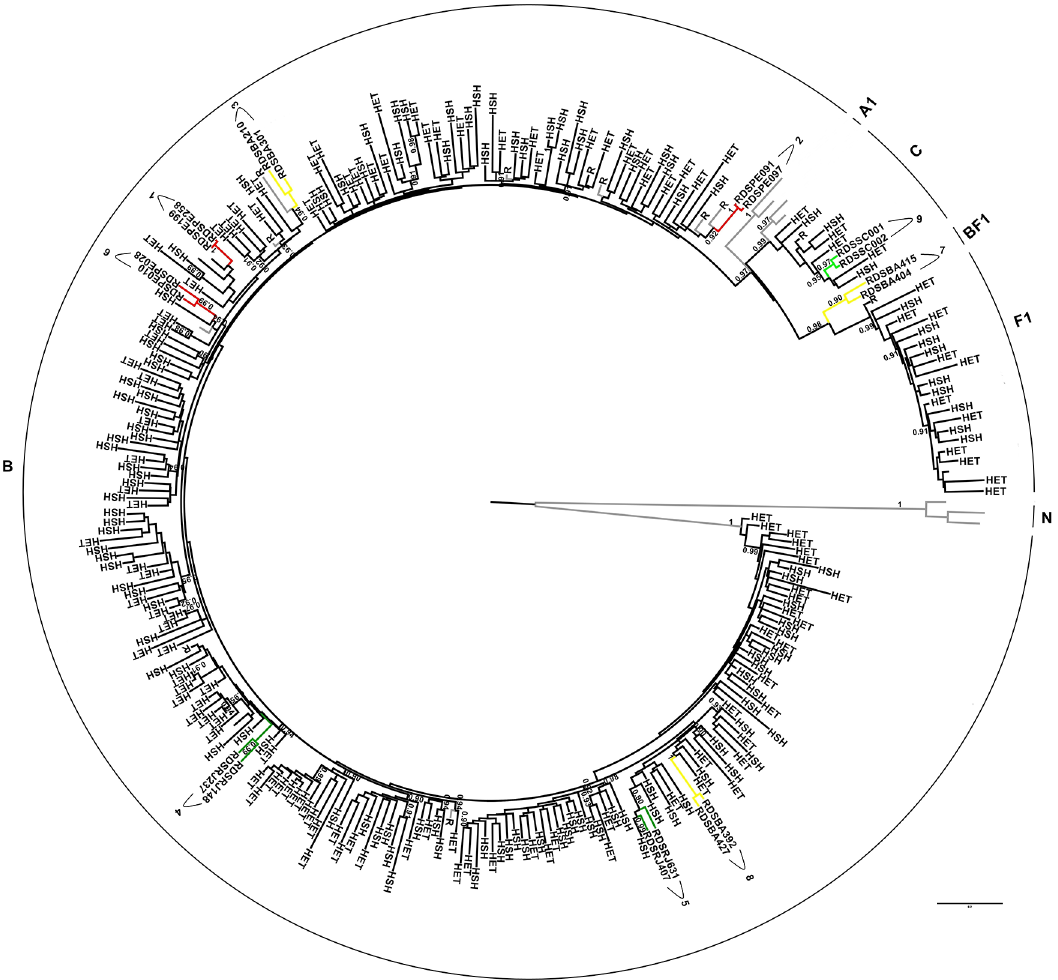
Fig 3. Env ML tree (6922 – 7277 relative to HXB2) from Brazilian RDS drug users clusters and reference sequences with highest similarity score to each group selected by HIV BLAST, as well as, Brazilian sequences with assigned transmission category [heterosexual (HET), homosexual (HSH), blood donor (BD) or vertical transmission (VT)] belonging to subtypes B, C and F1. The aLRT support values superior to 0.90 are indicated. Horizontal branch lengths are drawn to scale with the bar at the bottom indicating nucleotide substitutions per site.